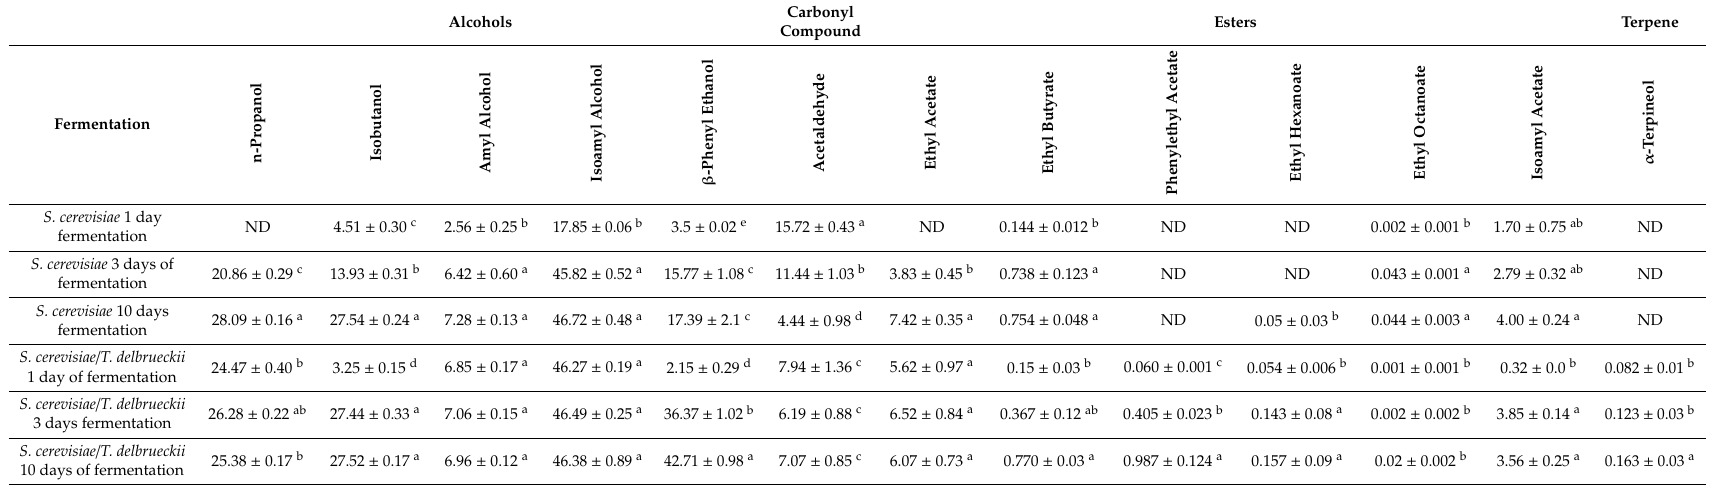
Table 2. Evolution of the main volatile compounds (mg / L) in the beer produced by pure ( S. cerevisiae ) and mixed fermentation ( S. cerevisiae / T. delbrueckii ) during the fermentation process. Data are means ± standard deviation. Data with di ff erent superscript letters ( a,b,c,d, ) within each column are significantly di ff erent (Duncan tests; p < 0.05). ND: not